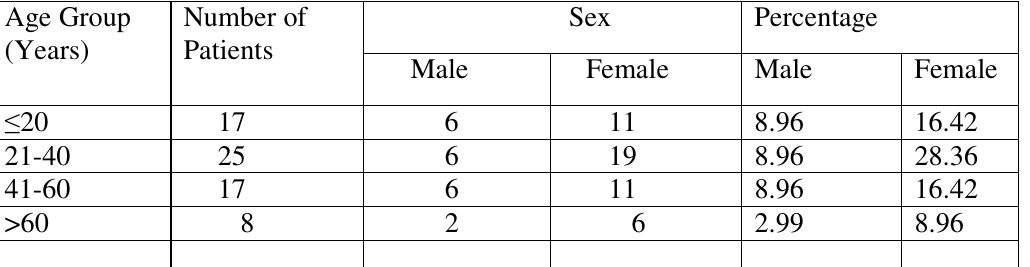
Table-4: Distribution of patients according to age and